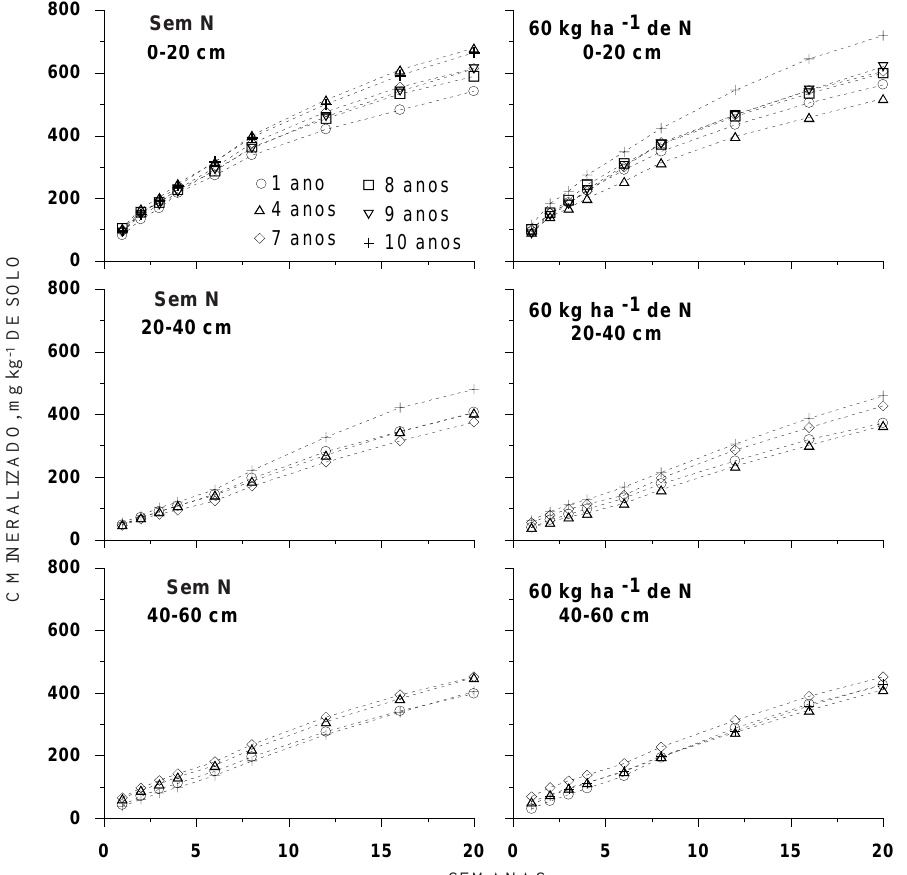
Figura 2. Mineralização acumulada de C-CO em 20 semanas de incubação, em amostras retiradas das 2 profundidades de 0-20, 20-40 e 40-60 cm de um solo PVA, em diferentes épocas após o início do cultivo com cana-de-açúcar, sem N e com 60 kg ha -1 de